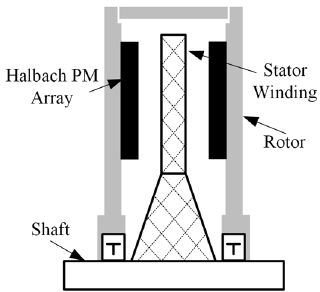
Figure 18 Sectional view of a DCPMSM